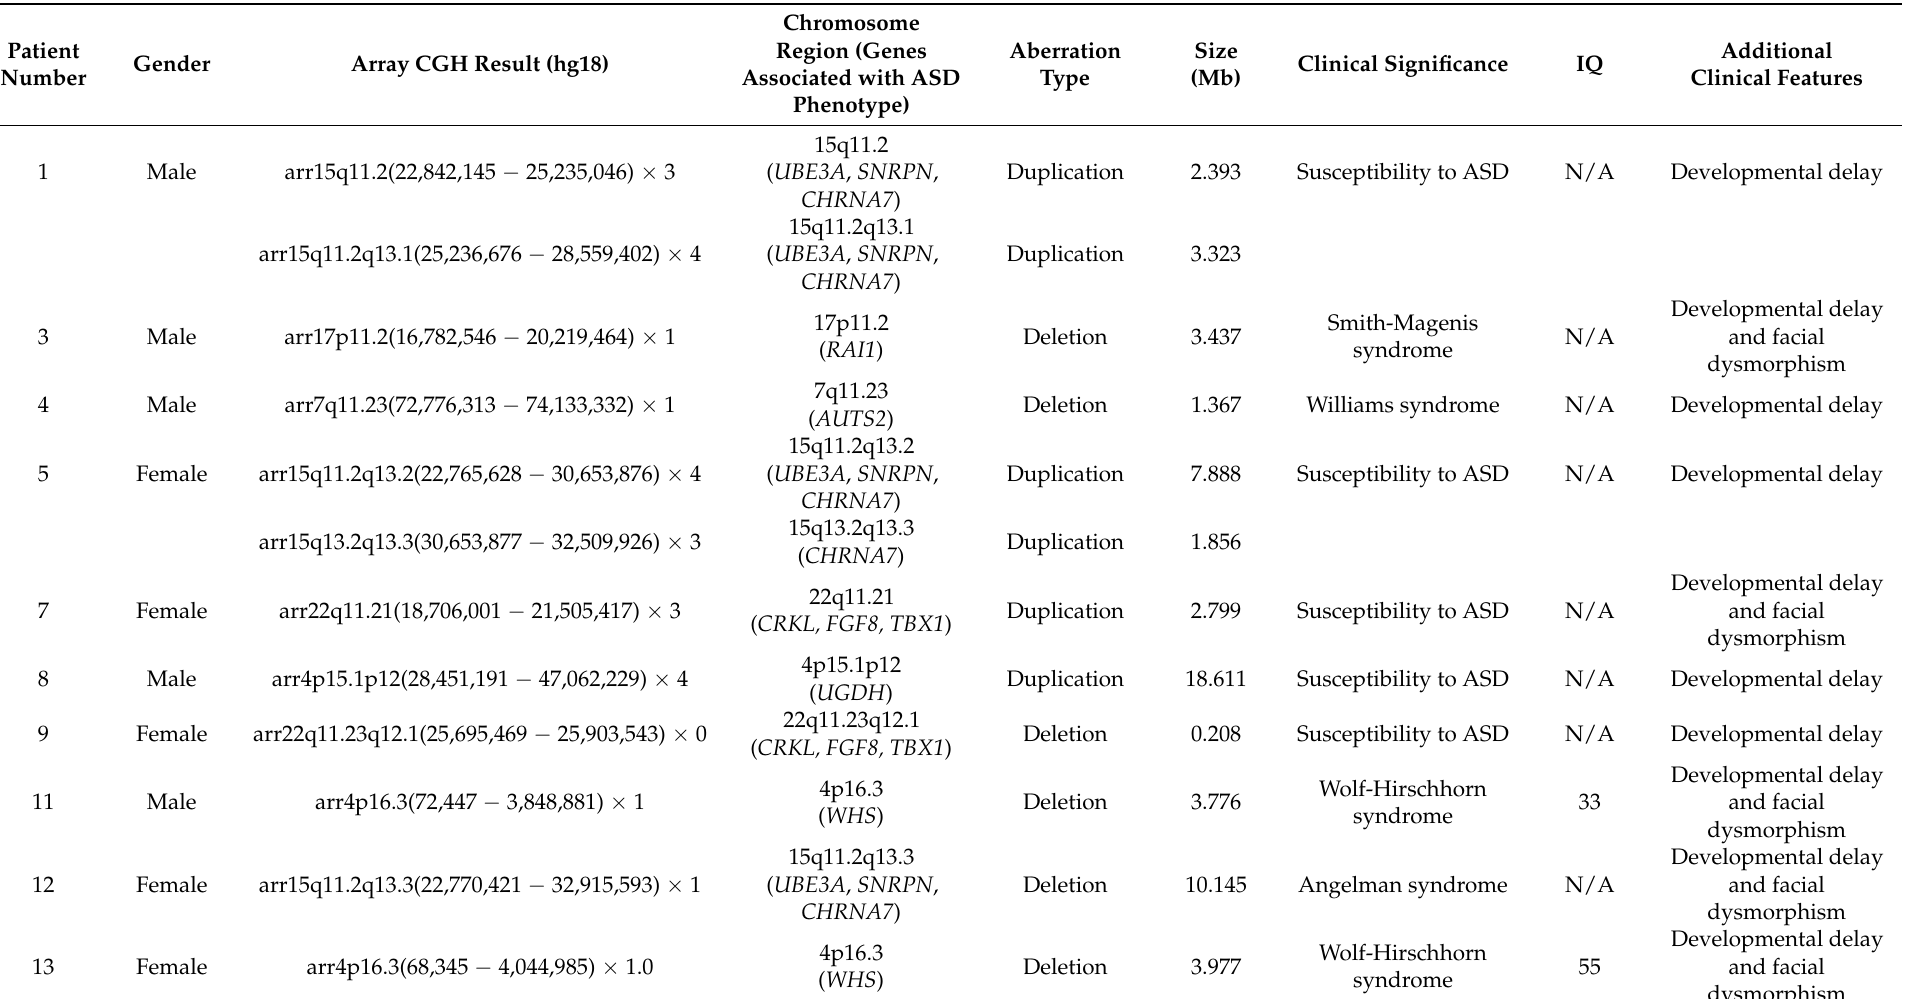
Table 2. Clinically significant